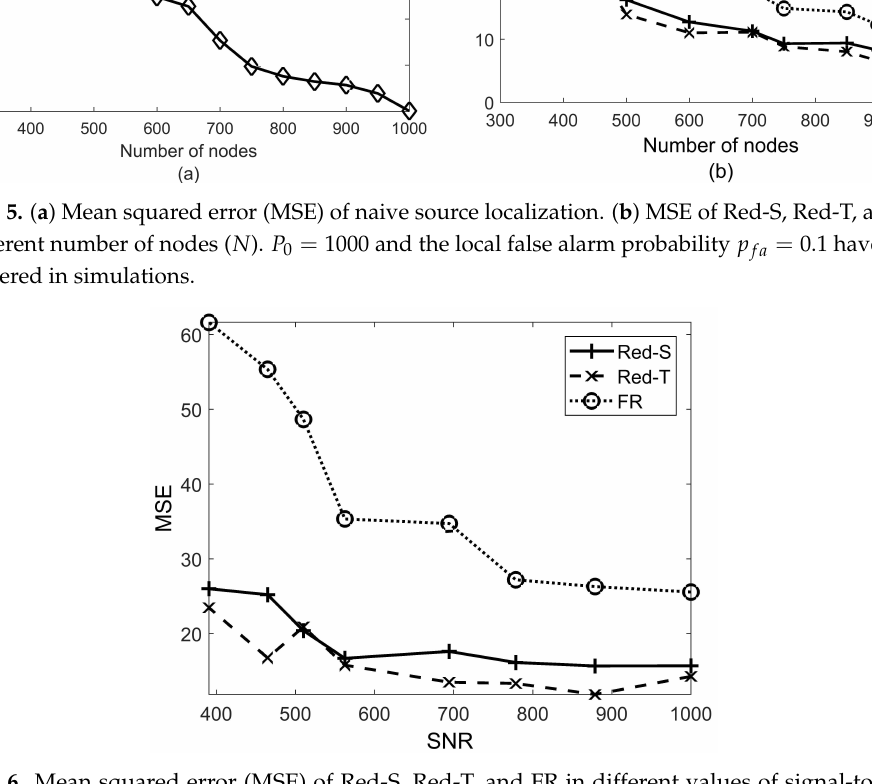
Figure 6. Mean squared error (MSE) of Red-S, Red-T, and FR in different values of signal-to-noise ratio (SNR) in a 500-node network. The local false alarm probability p fa = 0.1 has been considered in simulations.